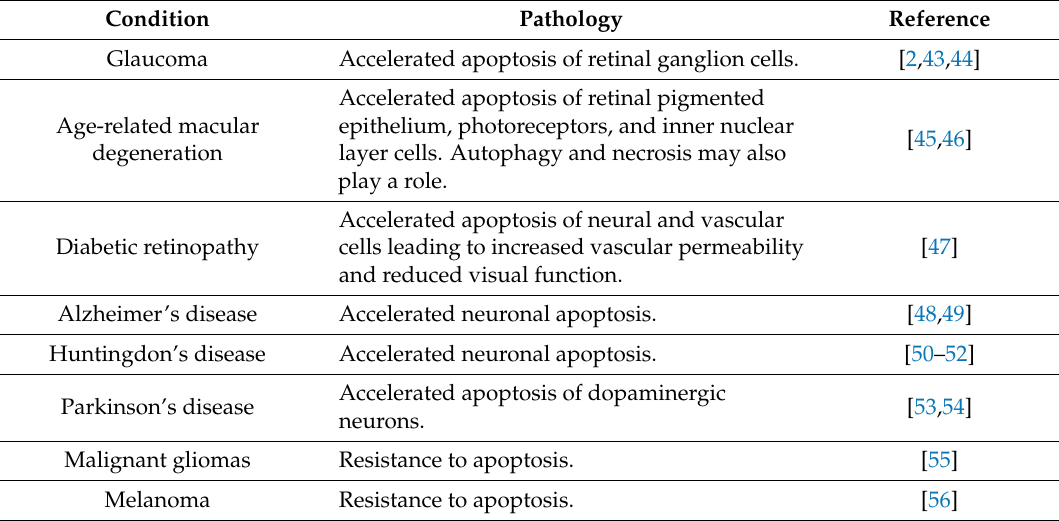
Table 1. Summary of some disorders in which apoptosis dysregulation has been